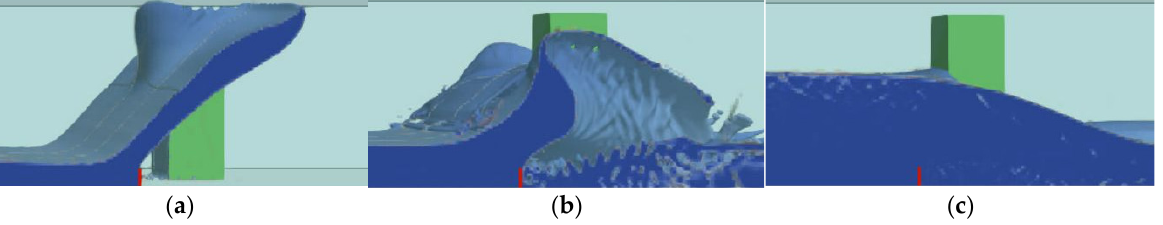
Figure 2. Snapshots of the surge interaction with the structure obtained from OF for Al-Faesly et al. (2012) domain: ( a ) time =1.8 s (Impact phase); ( b ) time = 2.8 s (run-up phase); ( c ) time =6.0 s (quasi- (2012) domain: ( a ) time = 1.8 s (Impact phase); ( b ) time = 2.8 s (run-up phase); ( c ) time = 6.0 s steady phase). (quasi-steady